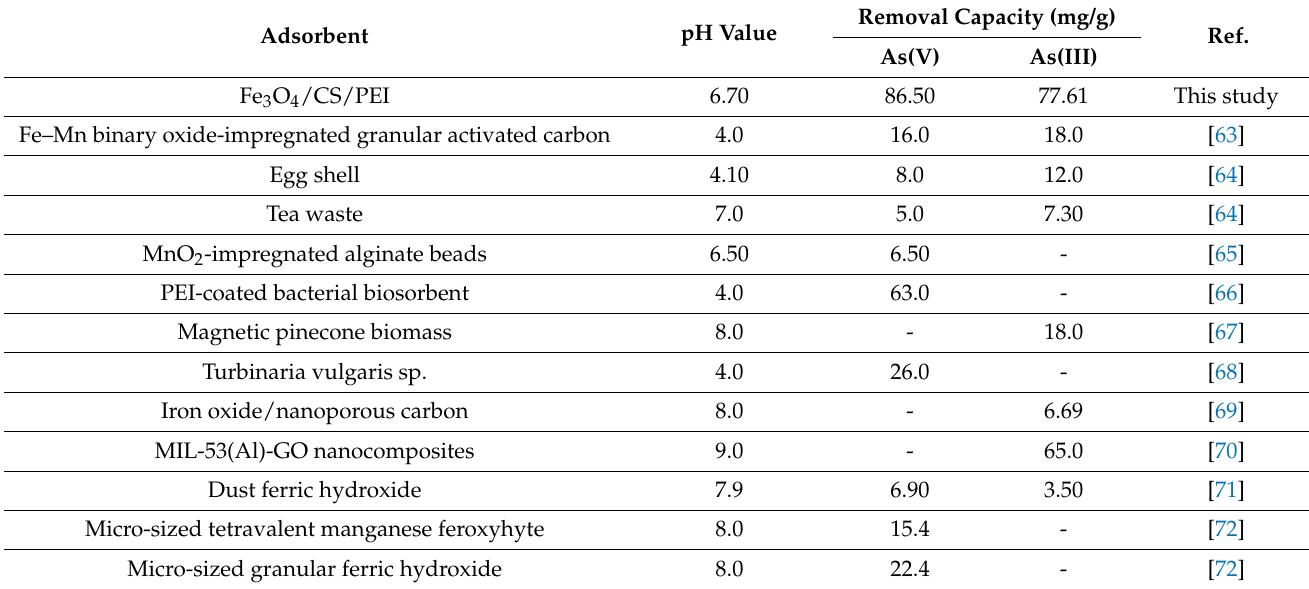
Table 2. Comparison of the adsorption capacity of Fe 3 O 4 /CS/PEI nanocomposite toward arsenic ions with other materials reported in the